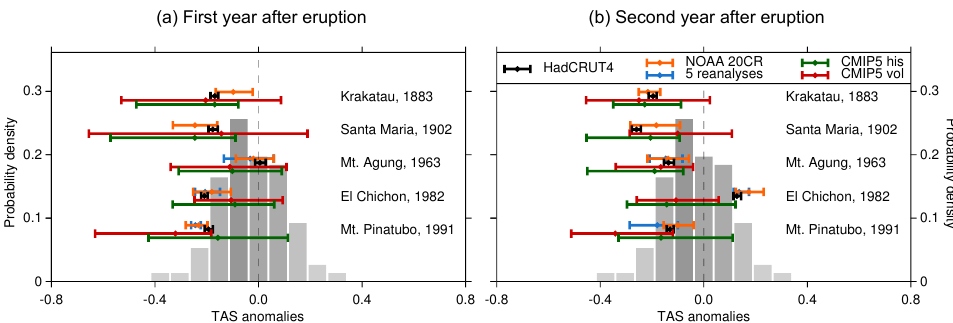
Figure 8. Tropical TAS anomalies (K) averaged over the region 30 ◦ S–30 ◦ N and over the first year (a) and second year (b) after five volcanic eruptions, calculated with HadCRUT4 observation data and reanalysis data. Anomalies are calculated with respect to the average over the years 1961–1990, consistent with the HadCRUT4 dataset. The histogram shows the anomalies of 153 years of observation data (1855–2007). The first and last 5 years are left out because of the trend removal. The blue lines show the reanalysis data spread of the TAS anomalies for the years after all eruptions except Krakatau and Santa María. The orange lines show the 90% ensemble spread of TAS after all five volcanic eruptions calculated with the NOAA-20CR dataset. The mean response is indicated by the dot between the